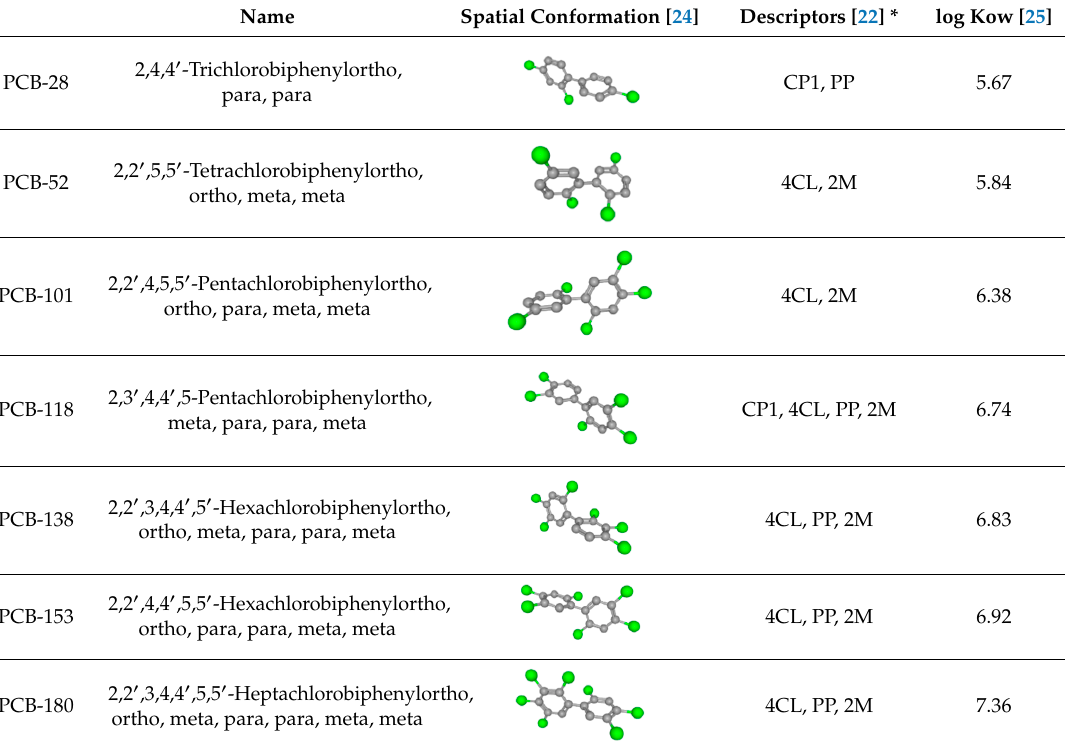
Table 2. Spatial conformation of marker PCBs.